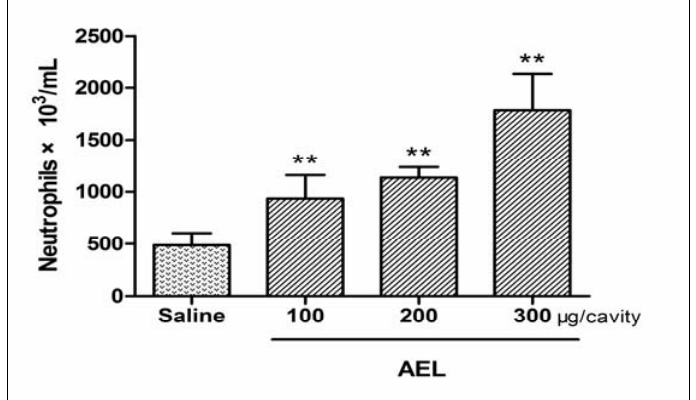
Figure 5. Neutrophil chemotaxis induced by AEL (100, 200 and 300 μ g/mL) was